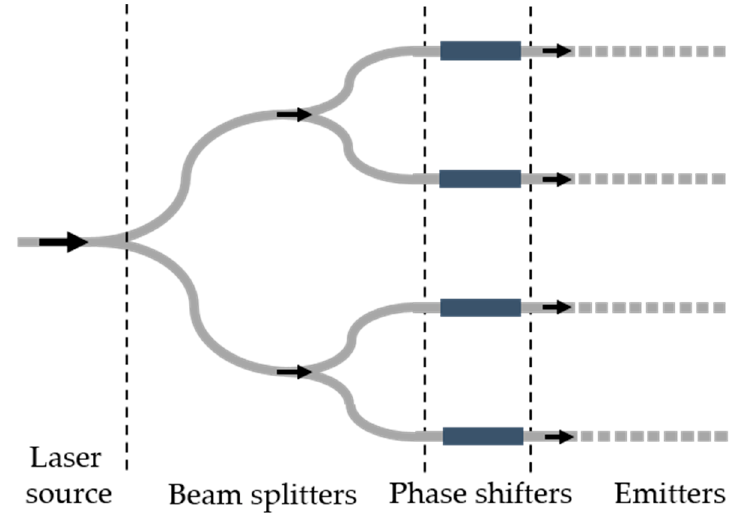
Figure 4. A typical integrated OPA structure.